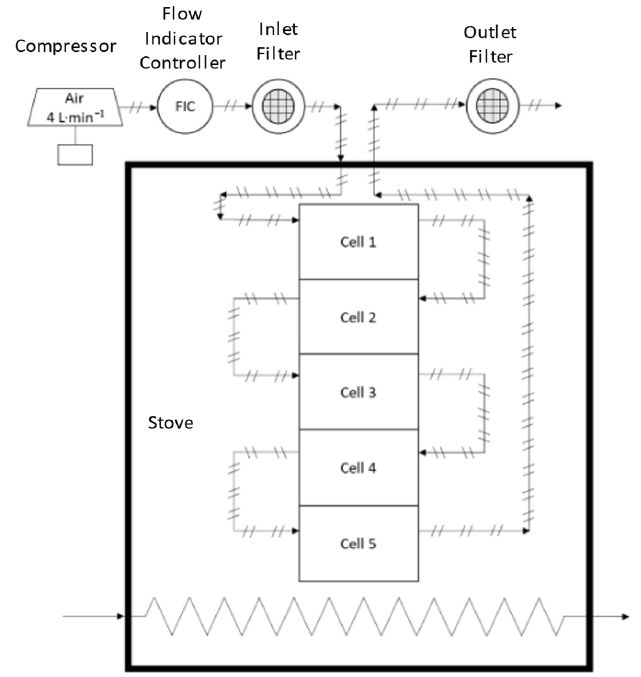
Figure 1. Flow diagram of process engineering of the Cascade System for Biomineralization in Cement.